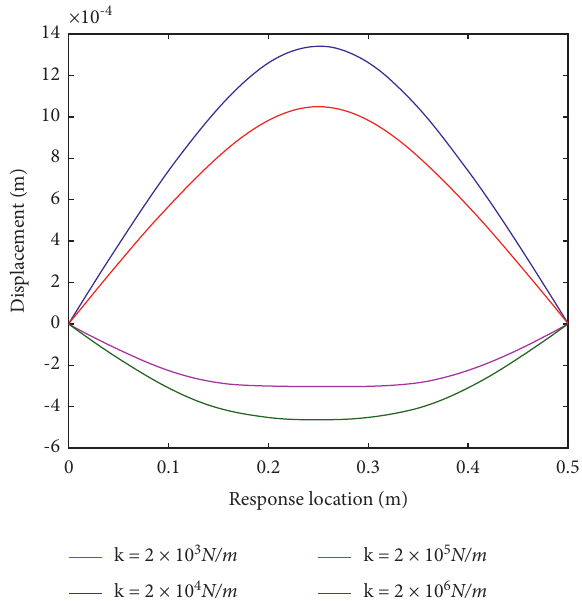
Figure 20: Vibration shape of beam 1 under different support stiffnesses.